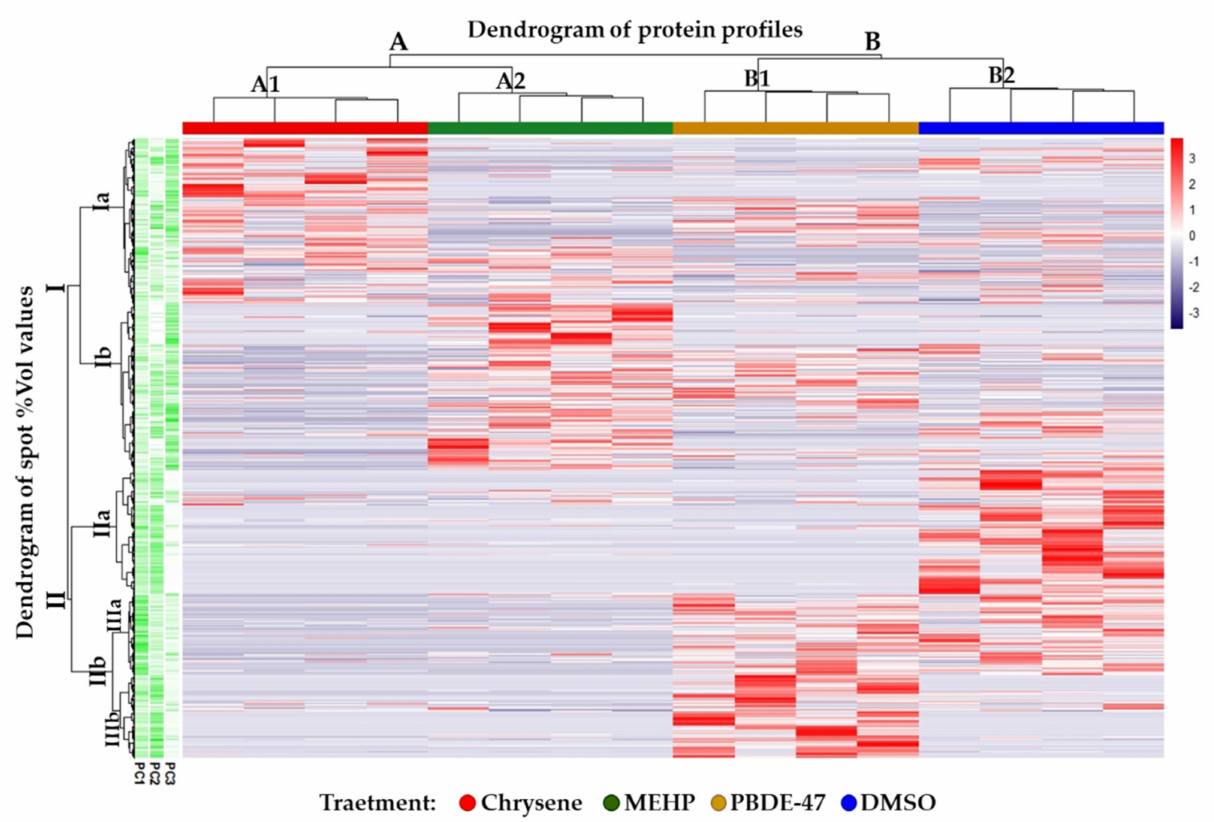
Figure 2. Spot intensity Heatmap. Tree clustered spot-intensity heatmap performed on all the spots. In column annotations, chrysene, MEHP, PBDE-47, and DMSO groups are represented in red, green, yellow, and blue, respectively. The row annotation gradients reported the absolute contributions of each spot in the first three Principal Components